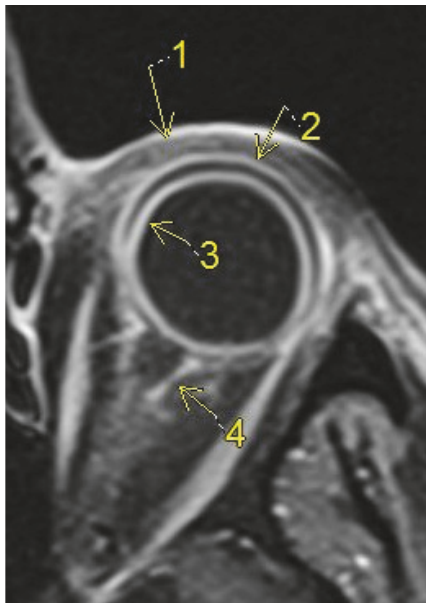
Figure3:AxialcontrastenhancedT1WIthroughtheleftorbitdemonstratingperiorbitalsofttissueswellingandenhancement(1)andsmooth circumferential enhancement of sclera (2) and choroid (3); enhancement of the left optic nerve sheath and retrobulbar fat (4).